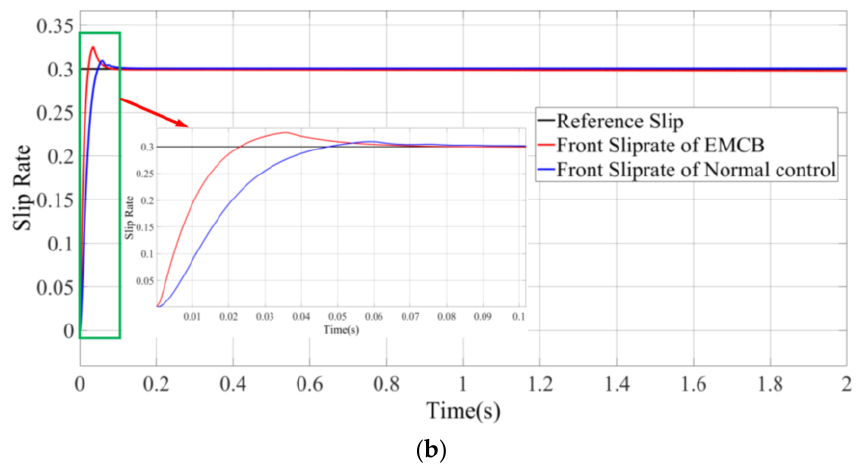
Figure 14. Braking performance of normal braking mode in pure electric state: ( a ) vehicle speed and wheel speed variation; ( b ) comparison of slip rate.